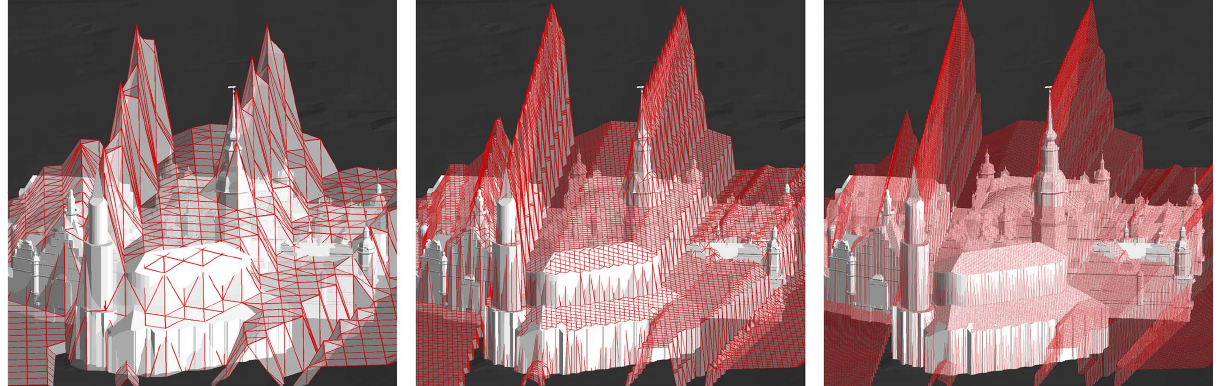
Figure 6. VPS imaging as 3d surfaces in different precision